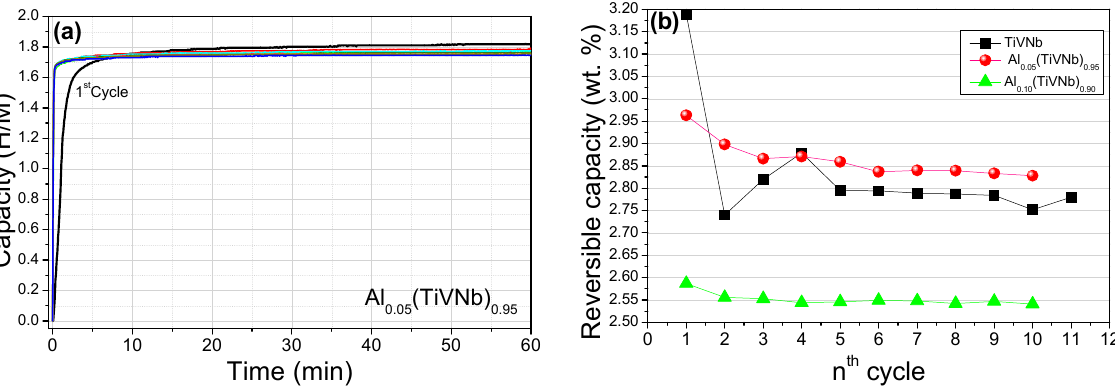
Figure 8. ( a ) Absorption kinetics under final P eq around 32 bar at 25 °C upon 10 cycles for Al 0.05 (TiVNb) 0.95 ; the first cycle is in black whereas the subsequent cycles are in color. ( b ) Comparison of the reversible hydrogen absorption capacity (wt.%) upon cycling for Al x (TiVNb) 1 − x (x = 0 [17], 0.05 and 0.10 [17]).